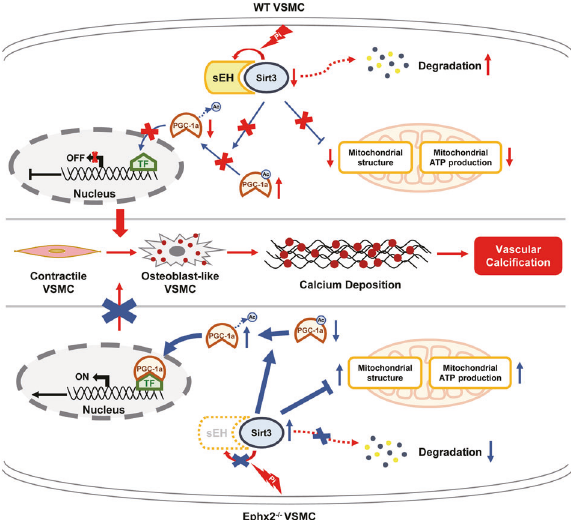
Fig. 6 Schematic cartoon showing the mechanism of soluble epoxide hydrolase (sEH)-related vascular calci fi cation. Under chronic kidney disease (CKD) condition, sEH interacted with Sirtuin 3 (Sirt3), leading to Sirt3 instable and degradation. This relative Sirt3 downregulation induced the increased acetylation of peroxisome proliferator-activated receptor γ co-activator-1 alpha (PGC-1 α ). Acetylated PGC-1 α could not exert its function on gene transcrip- tion. Furthermore, the mitochondrial adenosine triphosphate